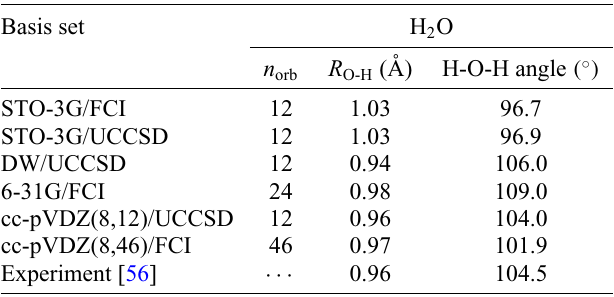
TABLE III. Structural property calculations of water molecule using different basis sets. The result from a given basis set is denoted with the abbreviation basis/method . The total number of spin orbitals used in the calculation is denoted as n orb . The equilibrium bond length and bond angle are obtained from the minimum-energy position coordinate of the corresponding two- dimensional potential energy surface.